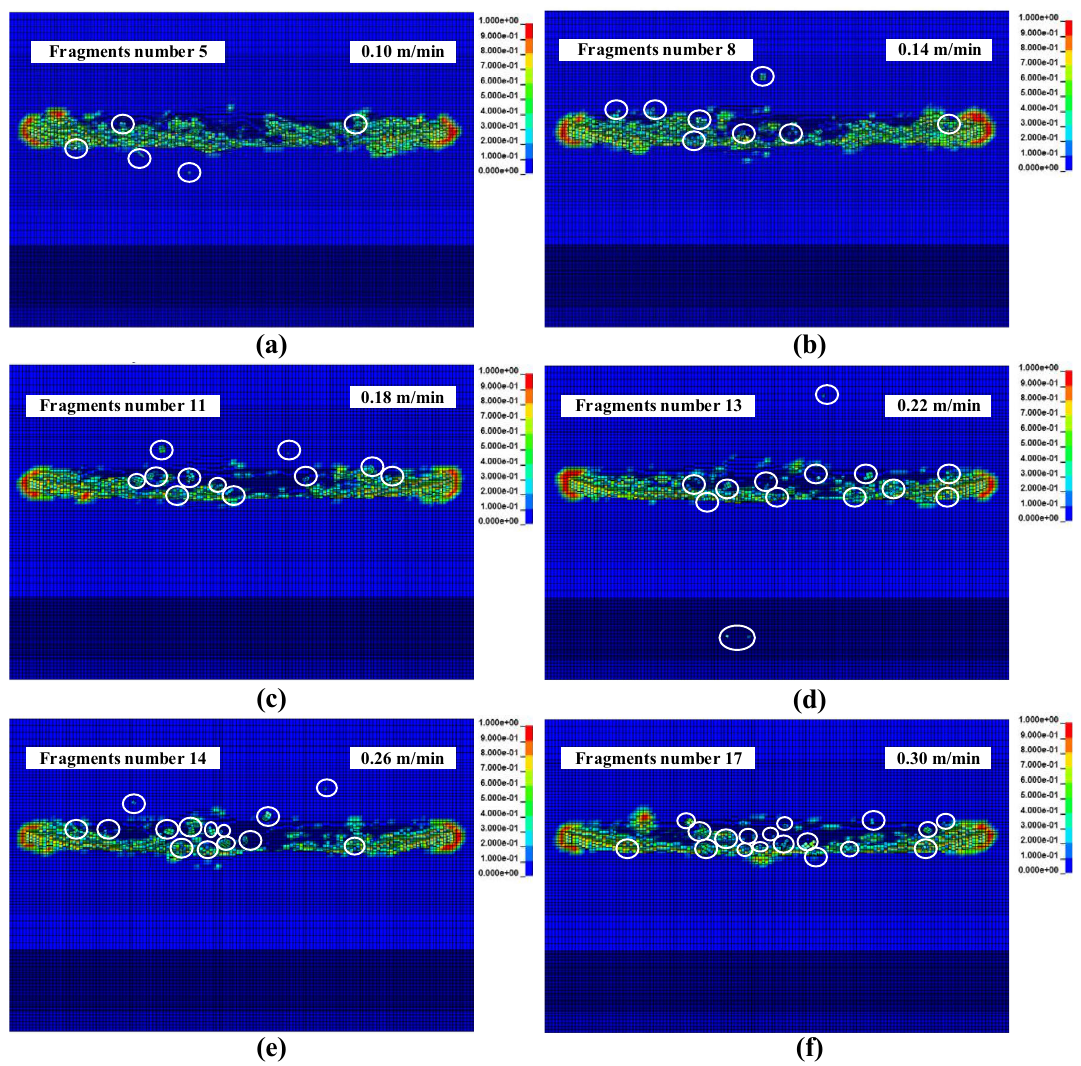
Figure 8. Rock fragmentation with a circular saw blade cutting at various feed